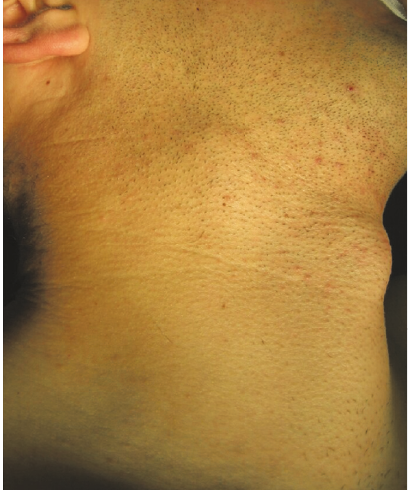
Figure 5: Painless palpable well-defined mass in the right carotid triangle.